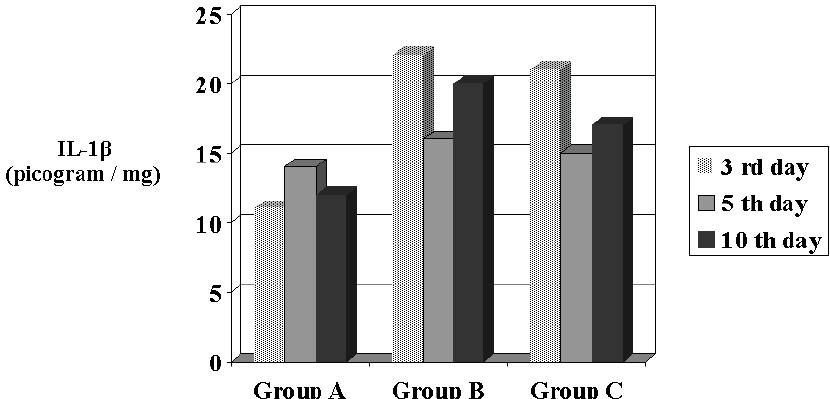
Figure 2. Levels of IL-1 β on the 3 rd , 5 th and 10 th days in Group A, B and C. There was no statistically significant difference throughout the whole follow-up period